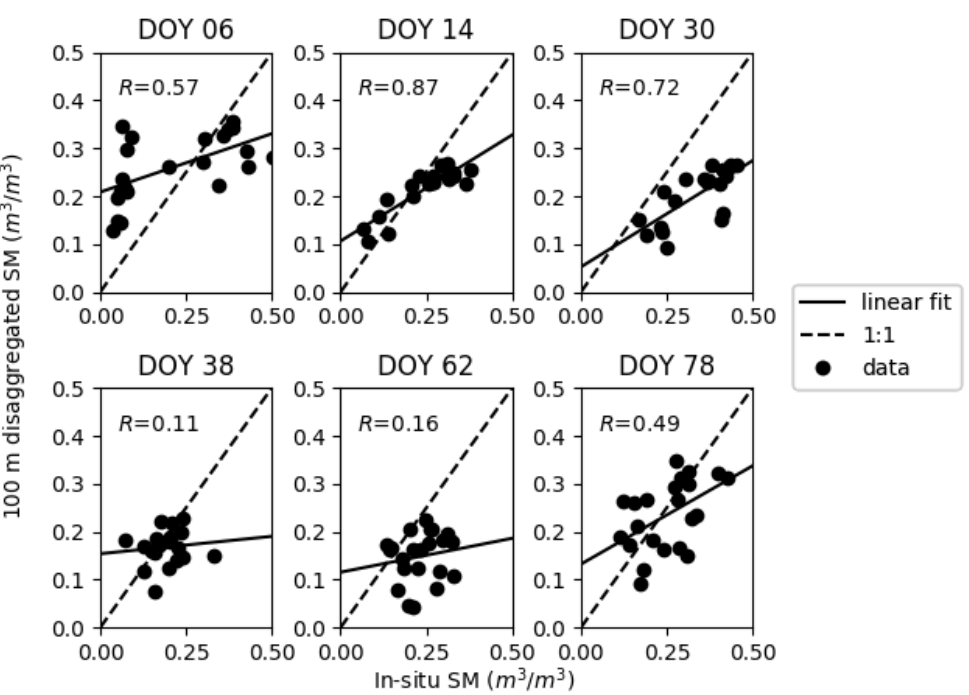
Figure 12. Same as Figure 11 but with LR SM set to the DISPATCH Lin SM obtained from SMAP and aggregated at 10 km resolution (single